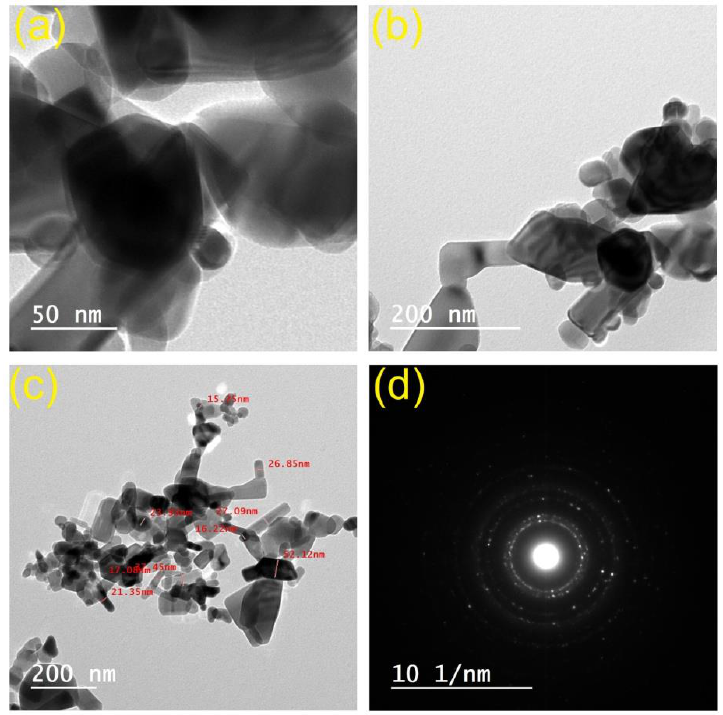
Figure 2. TEM images ( a – c ), and selected area (electron) diffraction ( d ) of SAPN. The XRD pattern of SAPN and its standard spectrum are shown in Figure 3. The